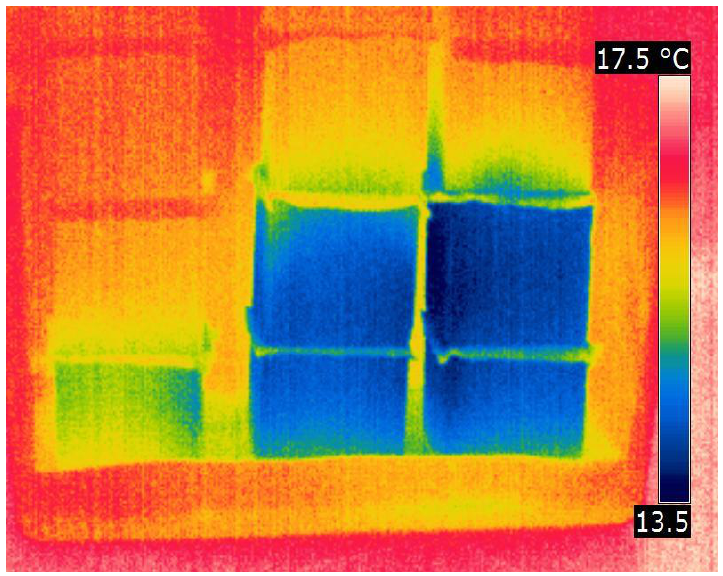
Figure A9. Thermographic report dated December 21, 2018, for Carparo (C.), Lecce stone (L.S.), and Tuff (T.).